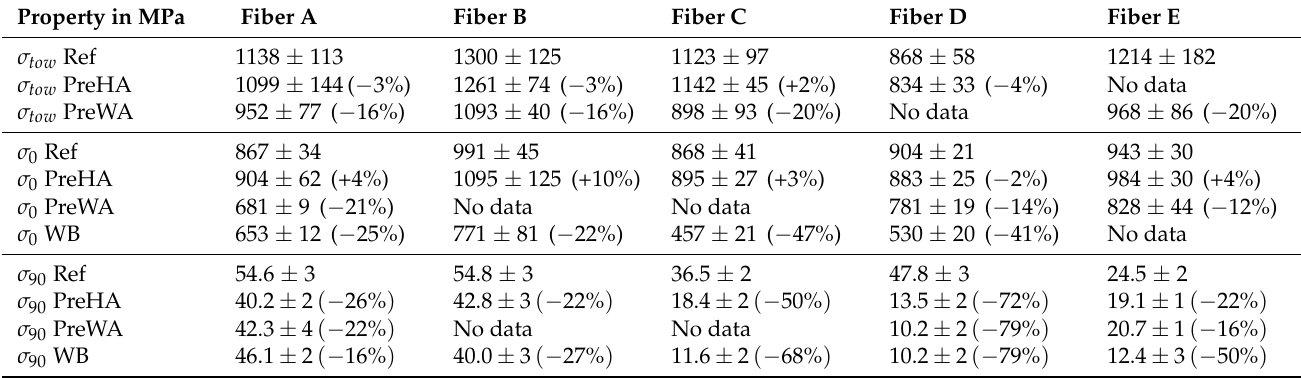
Table A1. Test results of the quasi-static fiber bundle, longitudinal and transverse tensile tests. Strength values are given in MPa and relative to the corresponding reference